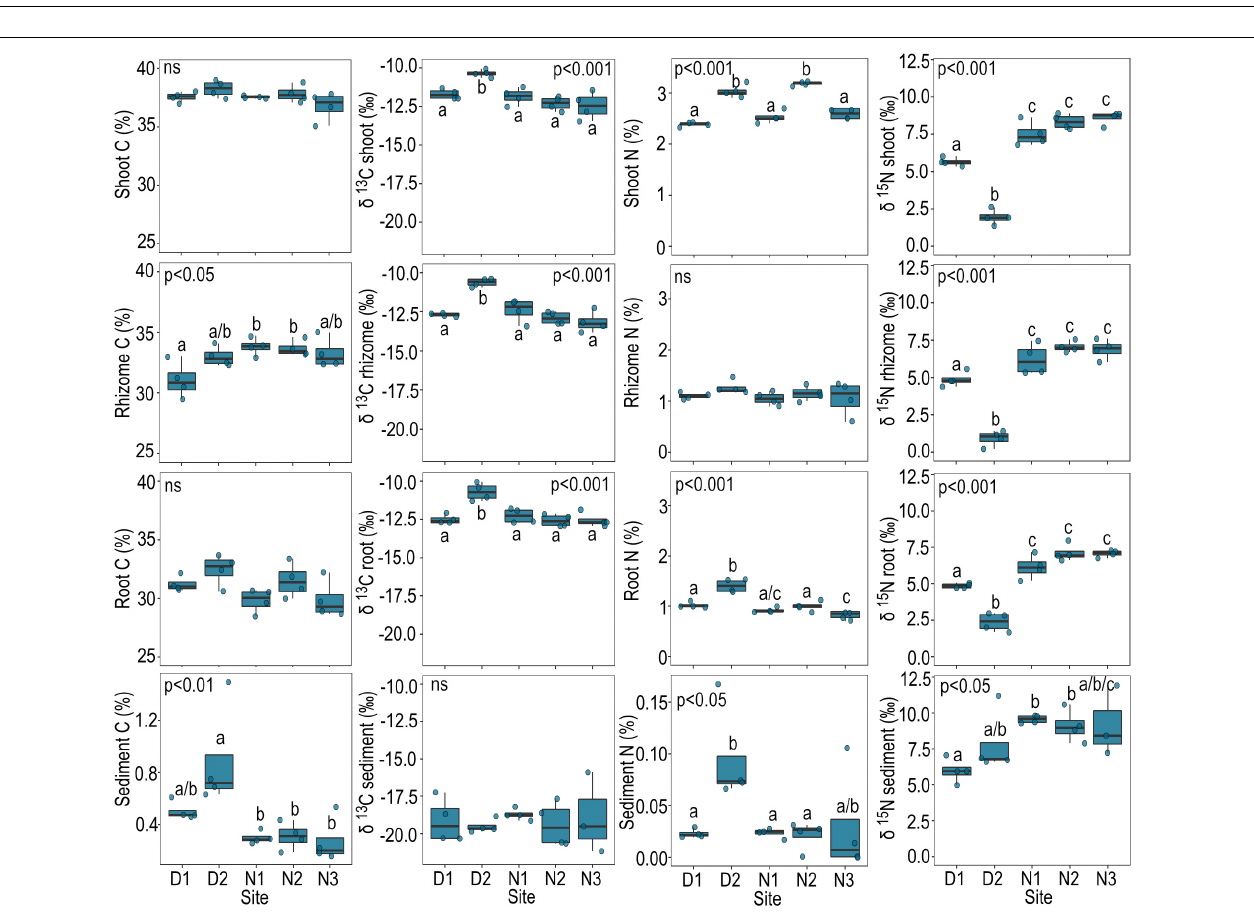
FIGURE 2 | Biomass (DW, dry weight) of H. ovalis by site. Data are boxplots with datapoints overlain. Significant post hoc comparisons between individual sites are indicated by lowercase letters. Ns, no significant difference among sites.